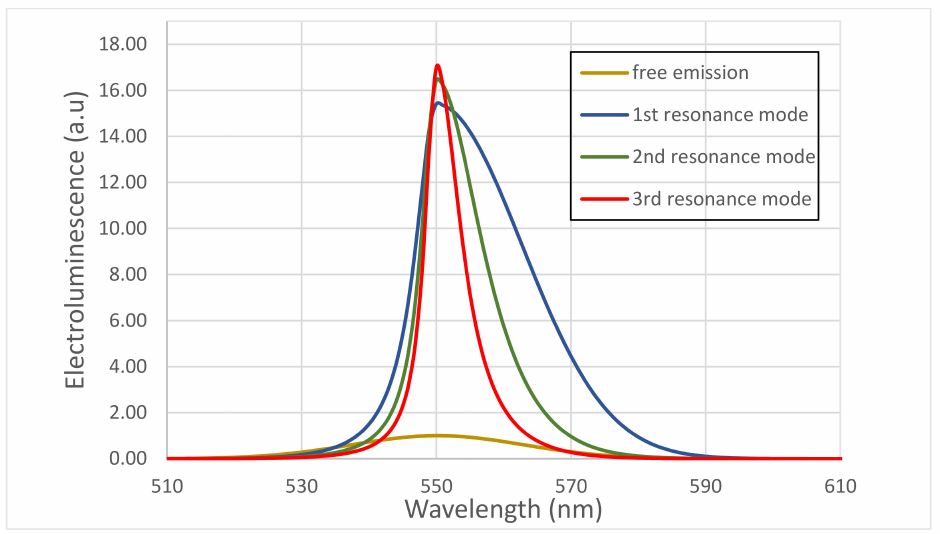
Figure 10. Electroluminescence spectra of device based on DBR3 at three-resonance mode.